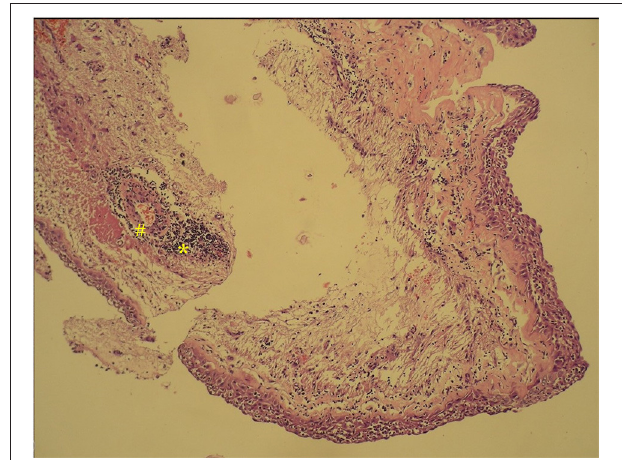
FIGURE 1 | Histopathology section of an adamantinomatous intraventricular craniopharyngioma, showing areas of wet keratin (#) with calcification (*).